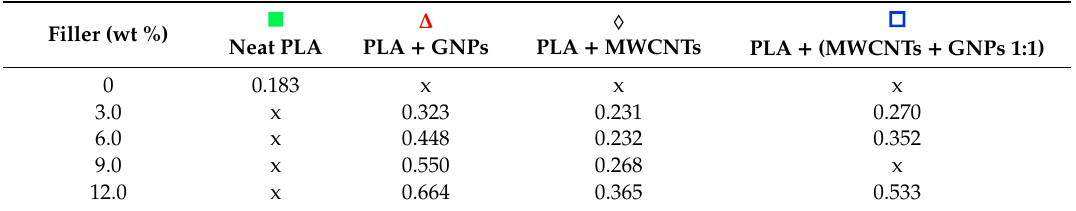
Figure 8. Thermal conductivity of carbon nanotubes (CNT)/PLA, GNP/PLA and (CNT + GNP 1:1)/PLA composites, as varying the filler contents. Markers represent experimental data, whereas lines are the interpolation curves. Table 2. Thermal conductivity (W/mK). Filler